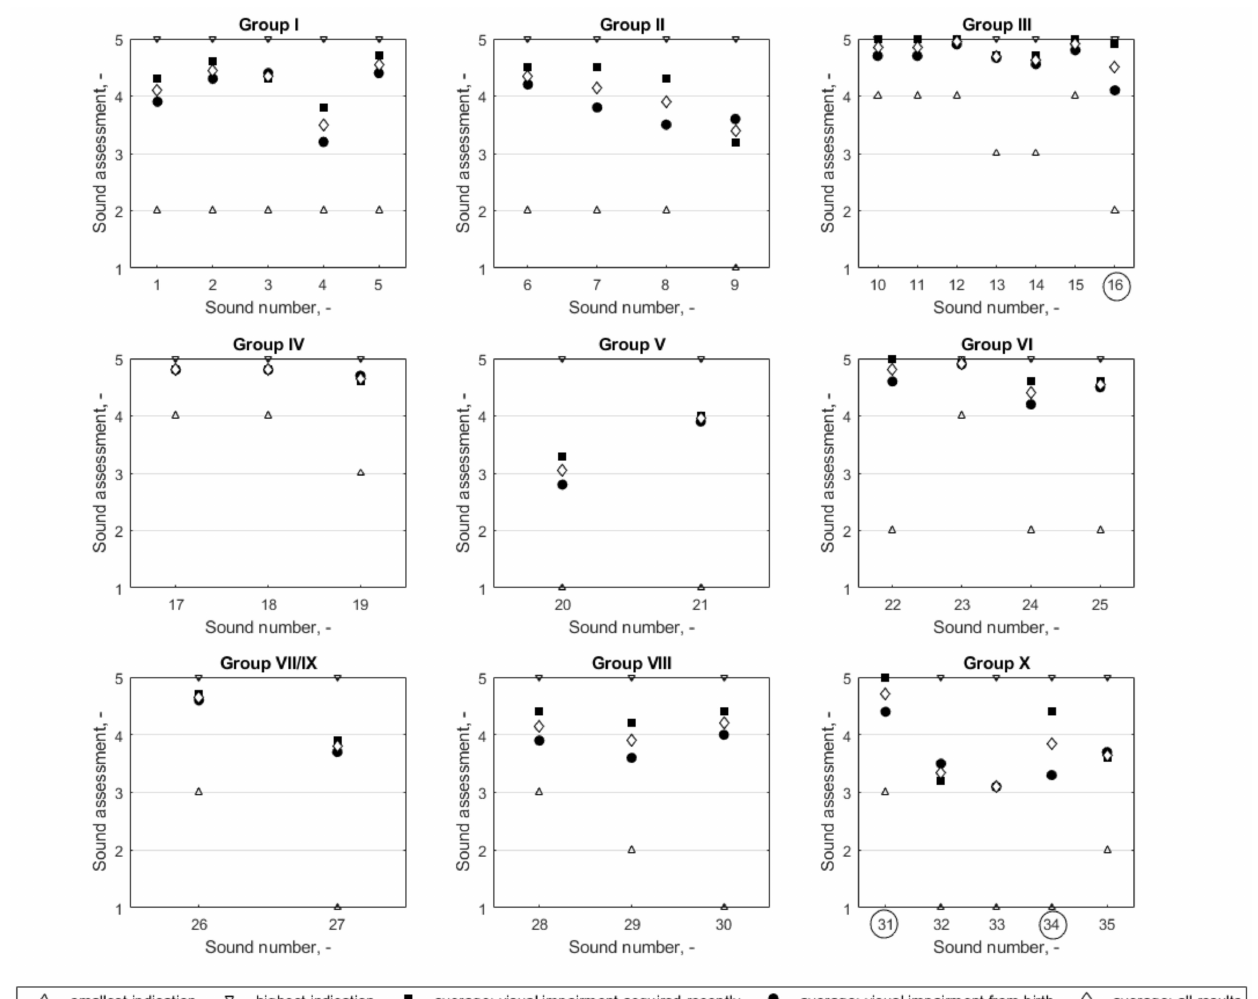
Figure 1. Evaluation of the proposed sounds. Sound numbers written inside the circles (16, 31, and 34) indicate cases when the differences between the average results of people who had a visual impairment since birth and who had developed an impairment relatively recently are statistically significant. Sound number designations: 1—an object falling onto a floor covered and not covered by carpet, 2—water dripping from a tap or shower head that is not completely off, 3—ring signal from a door entry phone, 4—conversations or sounds, e.g., from a radio heard through a wall, 5—knocking on a door, 6—steps on a staircase (sound reflections), 7—dog barking, 8—closing a gate, 9—low-flying passenger aircraft, 10—being surrounded by moving single-track vehicles (e.g., a scooter), 11—surrounded by moving two-track vehicles (e.g., passenger cars, trucks), 12—in the vicinity of moving rail vehicles (e.g., tram), 13—when staying on the pavement near a street with heavy traffic, at different distances from the street, e.g., 5 m, 10 m, 14—list of sounds present in the vicinity of streets with different traffic intensities, 15—signaling device at a pedestrian crossing, 16—bicycle bell, 17—a public bus pulling up to a stop, 18—the sound of a tram as it comes to a stop, 19—closing door of a public transport bus/tram, 20—engine operation, various types of vehicles, distinguishing between gasoline or diesel engines, 21—opening and closing a vehicle (car) door, 22—clapper sound, 23—a tram bell, 24—a signal to warn that a vehicle is driving backwards, 25—emergency vehicle signals, 26—vertical communication (passenger lifts), 27—reverberation in a building, 28—a xerograph or printer calibration suddenly starting, 29—a document being printed, 30—telephone ringing, 31—sound of a cyclist/person on rollerblades approaching on a cycling path, 32—bird sounds, 33—wind noise in the leaves of trees, 34—lawnmower powered by an internal combustion engine, 35—sounds coming from a playground for